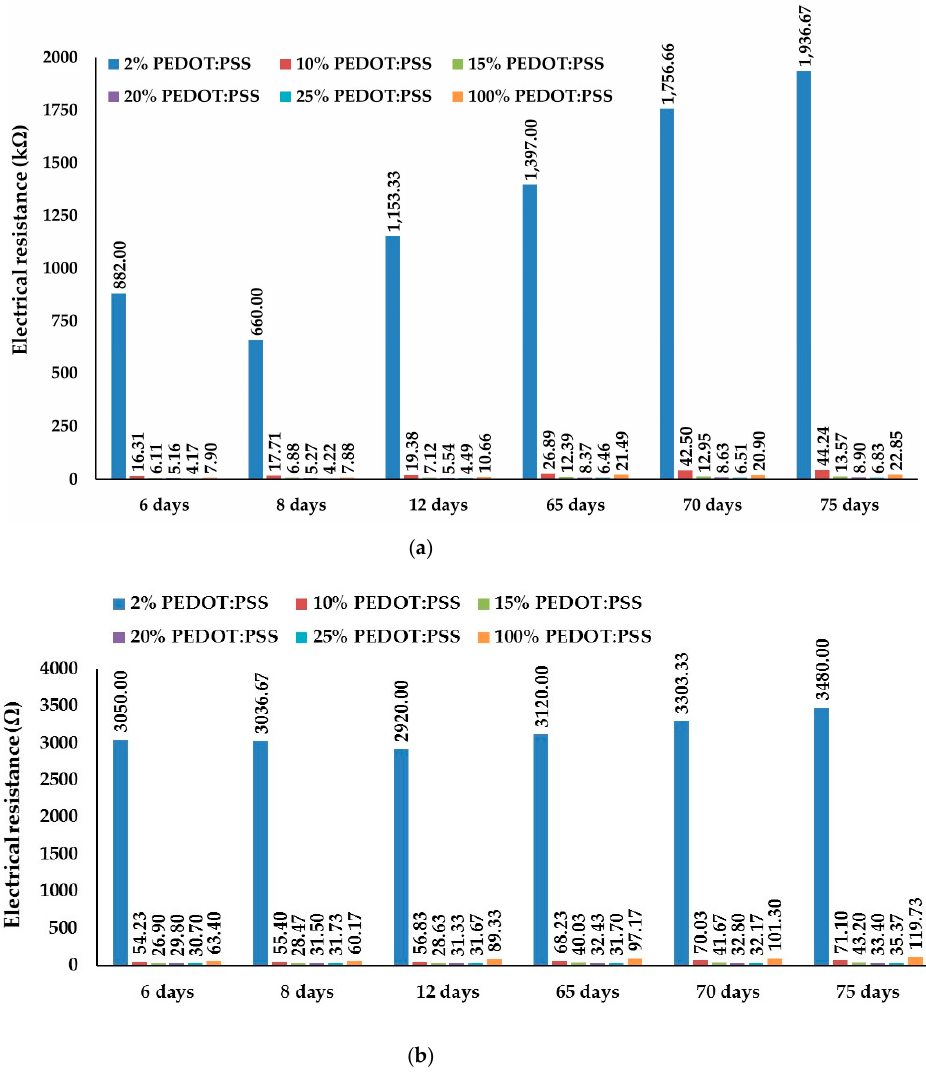
Figure 4. Electrical resistance of conductive dry films: ( a ) A/C dry film, ( b ) B/C dry film. Higher changes in electrical resistance of mostly all dry films can be observed after 65 days. 100% PEDOT:PSS B-dry films are more stable during observed period than 100% PEDOT:PSS A-dry films.